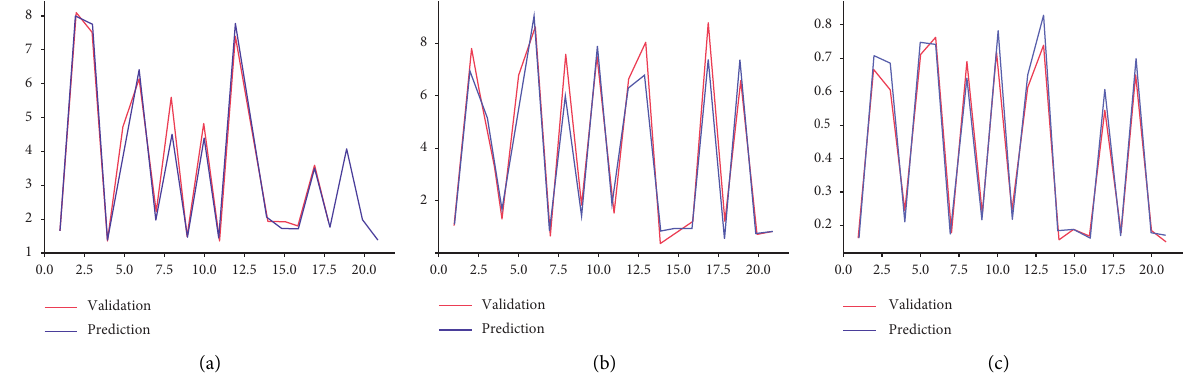
Figure 7: Real-predicted value curves: (a) real-predicted value curves of analyte wogonoside, (b) real-predicted value curves of analyte scutellarin, and (c) real-predicted value curves of analyte ferulic